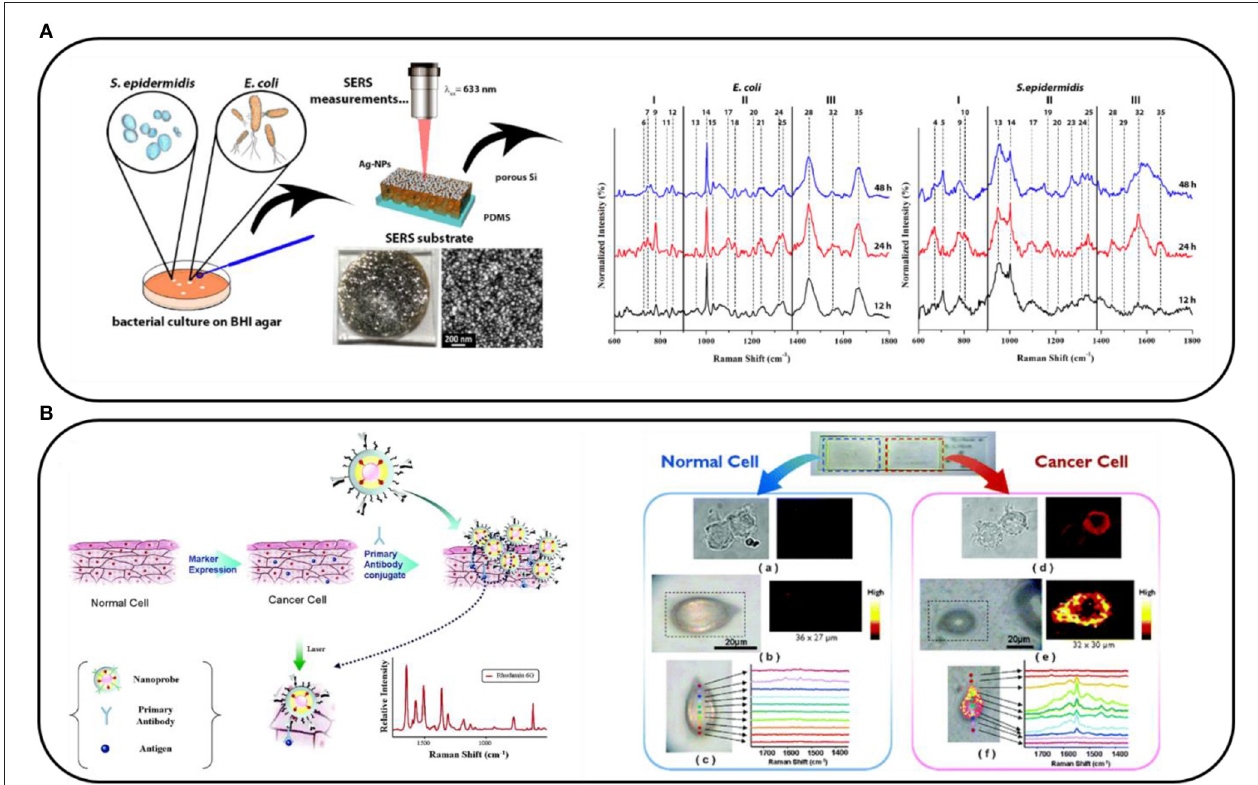
FIGURE 1 | (A) Scheme of the label-free surface-enhanced Raman spectroscopy (SERS) analysis of Escherichia coli and Staphylococcus epidermidis grown on the brain heart infusion (BHI) agar and their SERS spectra collected after 12, 24, and 48h of culturing. Adapted with permission from Paccotti et al. (2018). (B) Schematic diagram depicting the immobilization of Au/Ag core–shell nanoprobes on phospholipase C γ 1 (PLC γ 1)-expressing human embryonic kidney (HEK) 293 cells and SERS images of a normal HEK293 cell and a PLC γ 1-expressing HEK293 cell. Adapted with permission from Lee et al. (2007). Copyright (2007) American Chemical